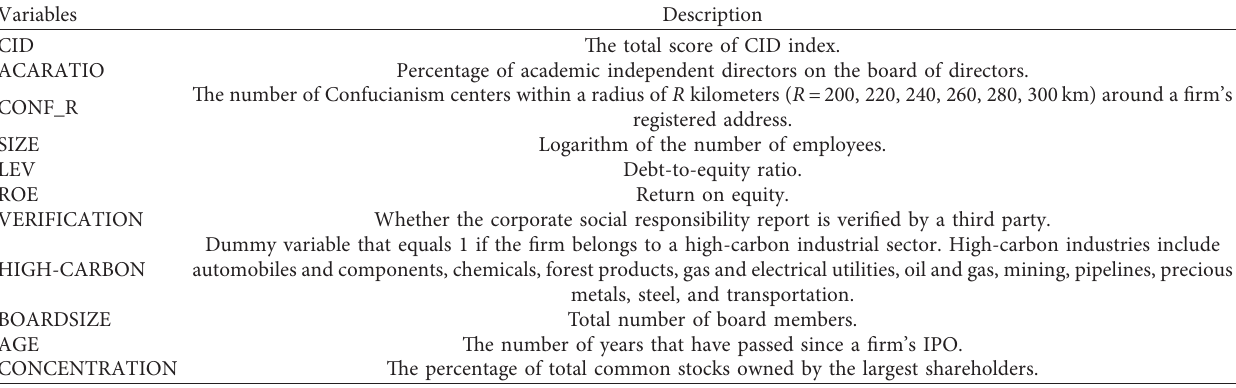
Table 2: Variable definition.